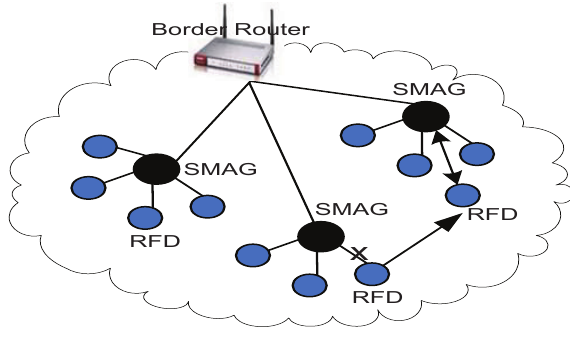
Figure 7. Inter-SMAG communication under same border